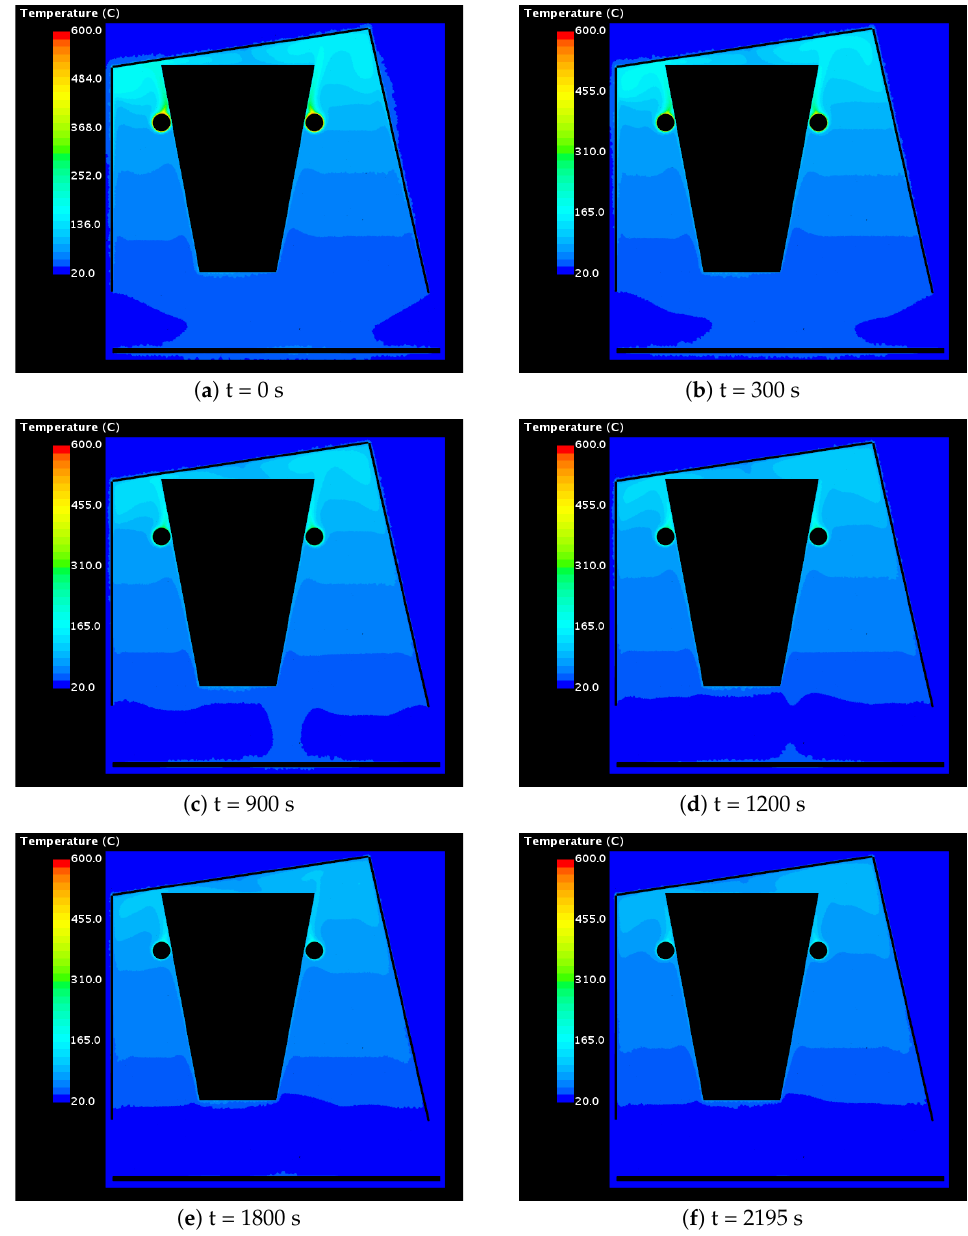
Figure 11. Simulation results for the temperature of the fluid in the central section